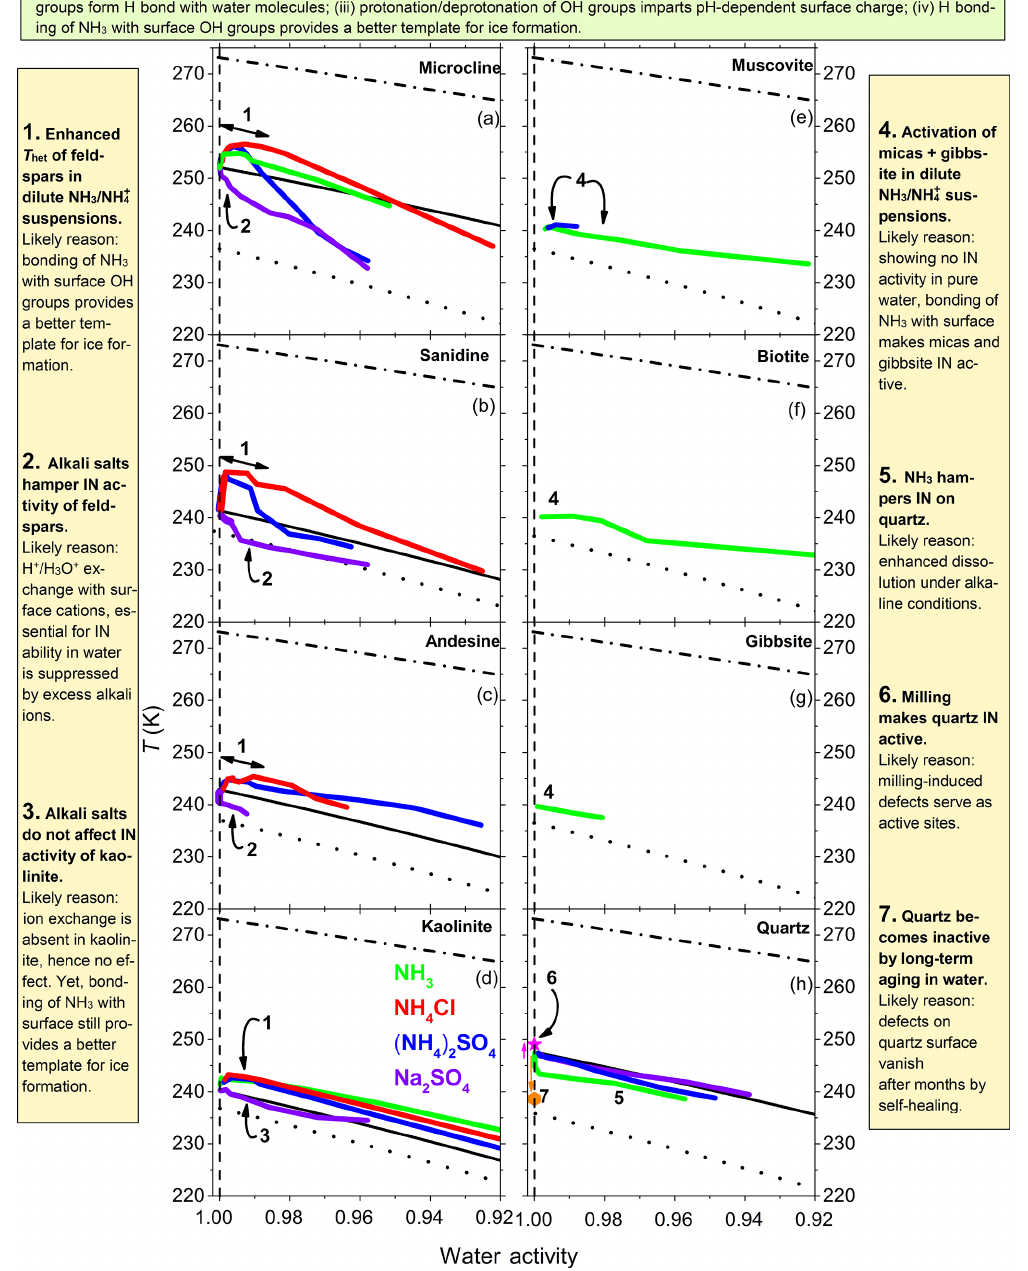
Figure 9. Annotated summary: heterogeneous IN onset temperatures, T het , of various mineral dusts (2wt%–10wt%) as a function of water activity in NH 3 , ( NH 4 ) 2 SO 4 , NH 4 Cl and Na 2 SO 4 solutions (color coded) for a w equal to 1.0–0.92. (a) Results for microcline from Kumar et al. (2018a). (b–g) Feldspars, kaolinite, micas and gibbsite investigated in the present study. (h) Results for quartz from Kumar et al. (2019). Dash-dotted black lines: ice melting point curves. Dotted black lines: homogeneous ice freezing curves for supercooled aqueous solutions. Solid black lines: expected heterogeneous freezing curves if the presence of solutes did not change the mineral surface properties. Lines result by horizontally shifting from the ice melting curve by a constant (cid:49)a het w emanating from the heterogeneous freezing temperatures of the suspensions of the minerals in pure water (at a w = 1). Specifically, (cid:49)a microcline w = 0 . 296, (cid:49)a sanidine w = 0 . 264, (cid:49)a andesine w = 0 . 254, (cid:49)a kaolinite w = 0 . 272 and (cid:49)a quartz w = 0 .